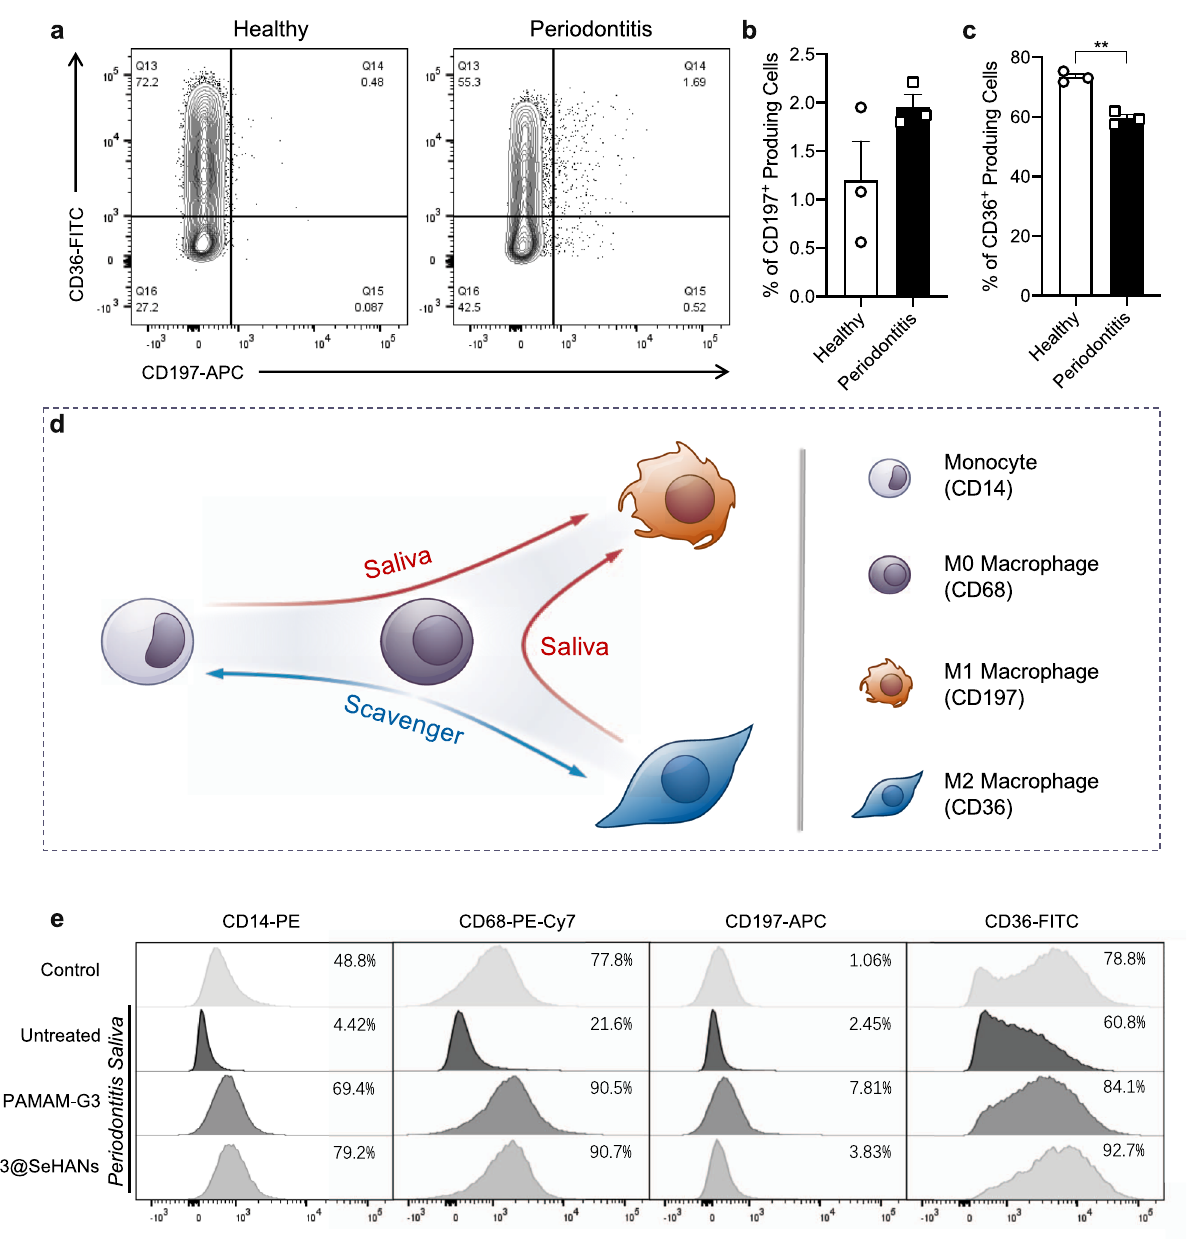
Fig. 7 | Effects of G3@SeHANs on macrophage polarization. a – c Expression of the M1 marker CD197 and the M2 marker CD36 in THP-1 cells activated by peri- odontitis saliva. Data are means±SEM; differences were assessed by two-tailed Student ’ s t- test ( n =3 samples per group) ( c , P =0.0011). d Schematic